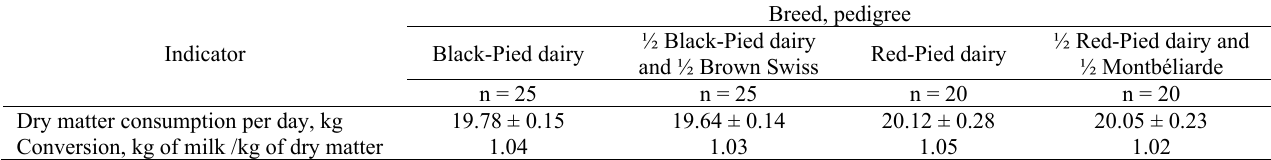
Bioenergetic characteristics of the first-calf heifers (M ± m) Indicator Black-Pied dairy